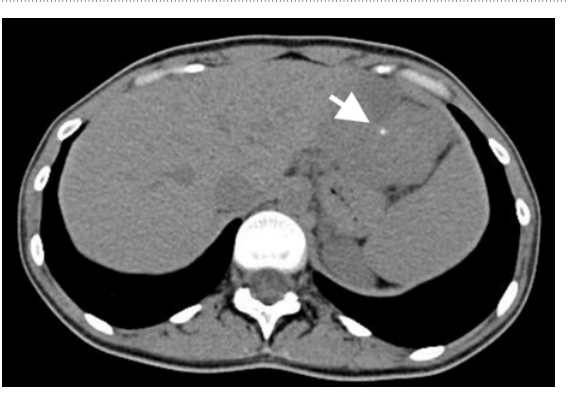
Figure 2. Portal venous CT image depicting hypoattenuated areas of